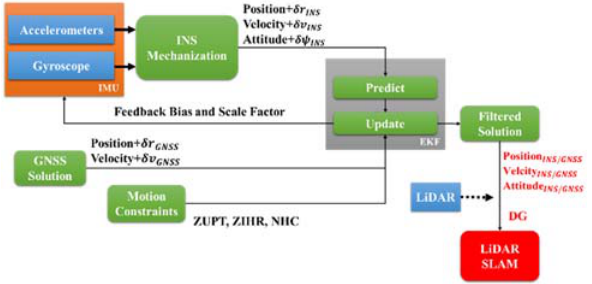
Figure 1. The flow chart of data